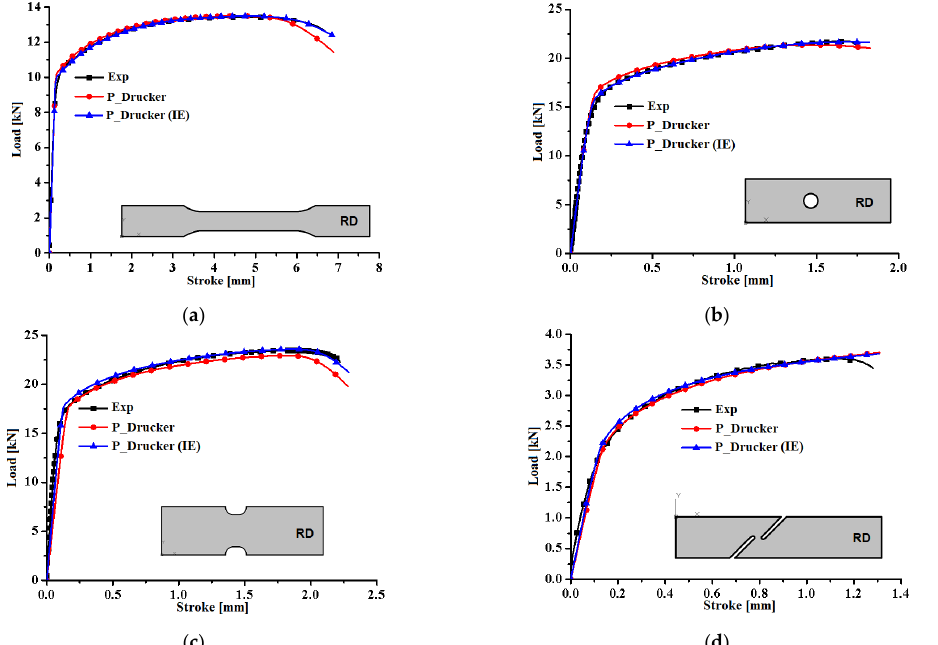
Figure 11. Comparison of the prediction error value before and after parameter optimization.